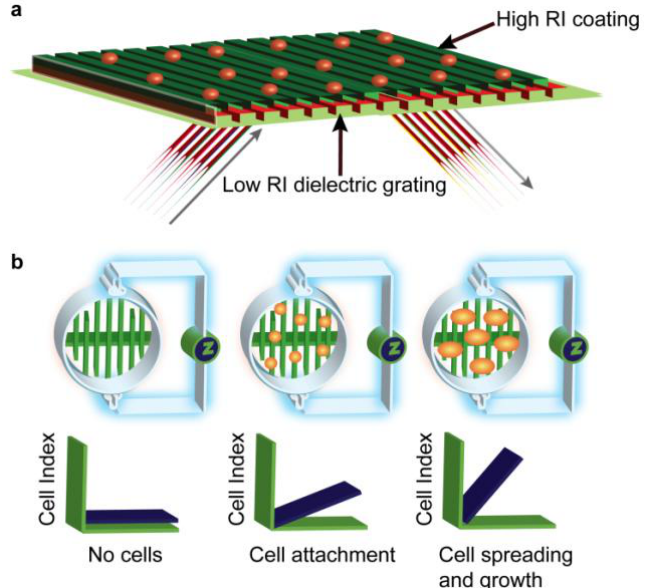
Figure 1. Overview of optical resonant waveguide and cell impedance label-free platforms. ( a ) Cross-section of the resonant waveguide grating optical biosensors in each well of a 384-well plate. A coating with a high index of refraction on the sensor surface reflects only a narrow band of wavelengths when illuminated with an optical beam. The incident angle of the reflected beam is sensitive to mass redistribution within the cell up to ~150 nm from the surface [17]; ( b ) Cells are plated onto gold microelectrode arrays, which when stimulated with a low voltage; generate an electric field sensitive to changes in the properties of a cell. Impedance measurement in Cell Index (CI) is zero when cells are not present. The impedance increases as cells attach and spread across the electrodes